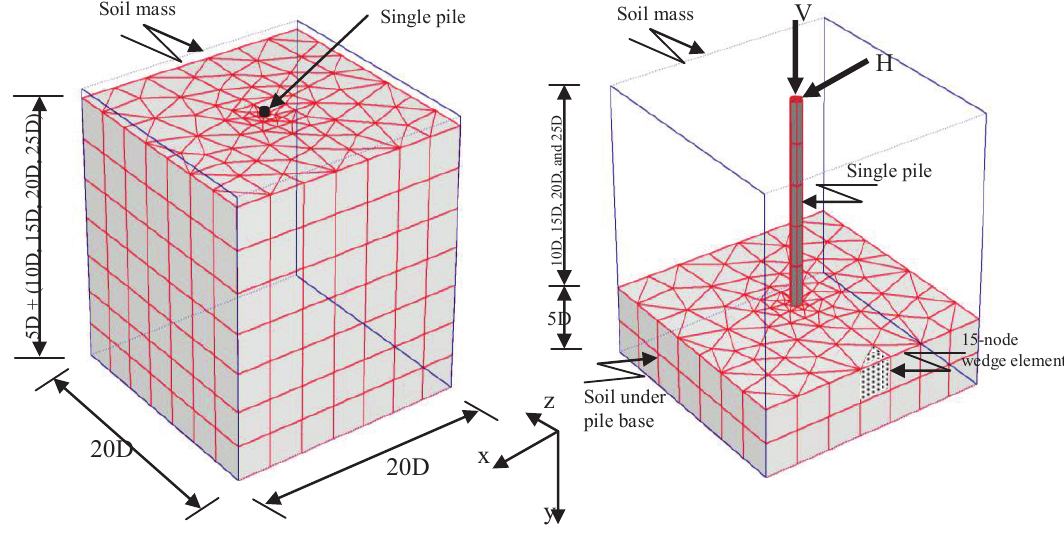
Figure 2 Three dimension of finite element mash for single pile and surrounded soil mass Figure 2: Three dimension of finite element mash for single pile and surrounded soil Validation of numerical model